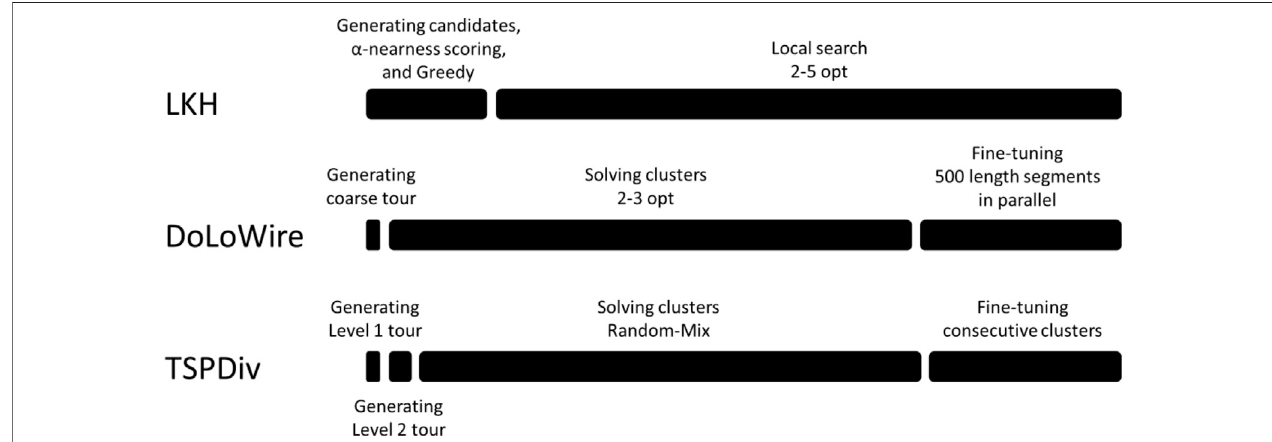
FIGURE 13 | Pro fi ling of submitted methods over the course of 1